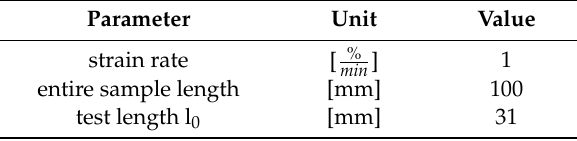
Table 2. Boundary conditions of the tensile